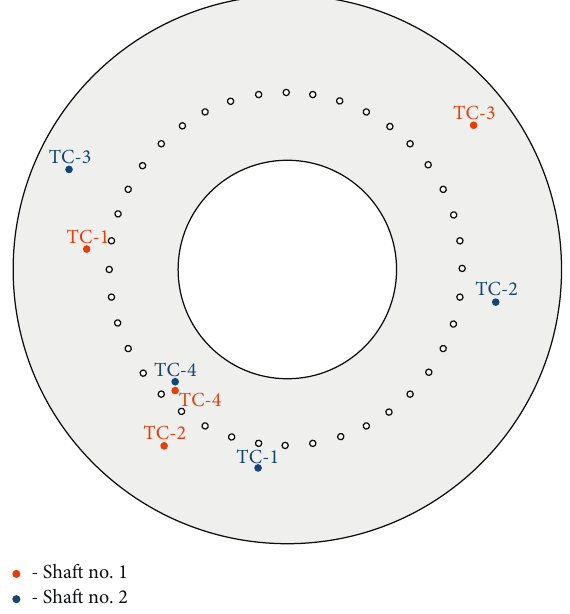
Figure 1: Con fi guration of the computational domain: a horizontal layer of soil with the contour of freezing pipes and TC boreholes. The red TC boreholes correspond to shaft no. 1, and the blue ones correspond to shaft no. 2.